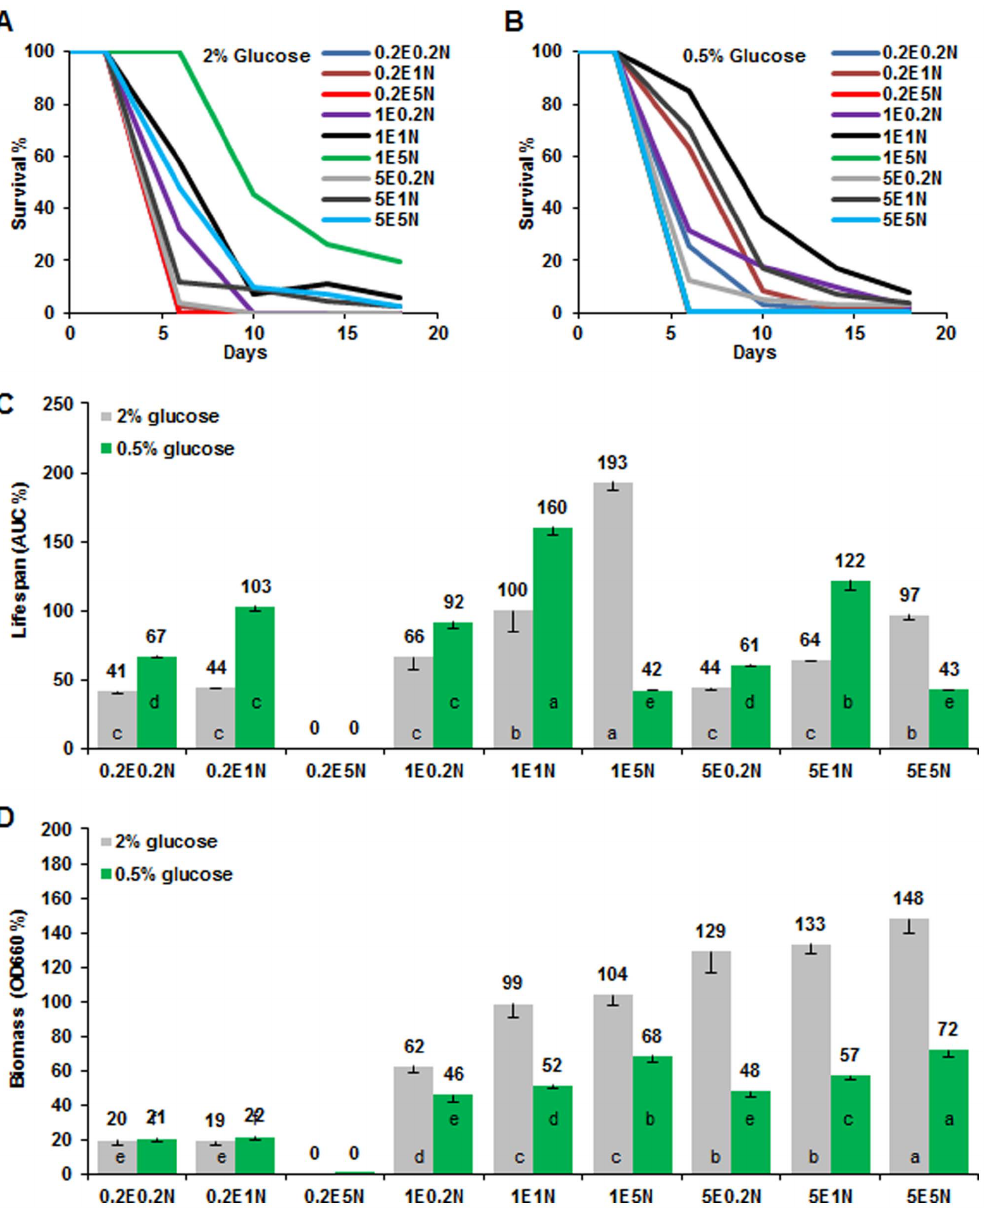
Figure 1. Ratio of essential and non-essential amino acids regulates lifespan and biomass changes. Survival curves of wild type yeast (BY4742) were cultured in SD media with different ratios of EAA (0.2 to 5 fold) and NEAA (0.2 to 5 fold) in normal (2% glucose, A ) and glucose restriction (0.5% glucose, B ) conditions. The normalized lifespan and biomass comparison were presented in C and D , respectively. All tests were based on SD media. 1E5N represents SD medium containing 1-fold EAA and 5-fold NEAA. The EAA and NEAA compositions and concentrations (1 fold) were listed in Table 1 . Area under the survival curve (AUC) represents the survival integral for lifespan comparison and AUC of the control (1E1N with 2% glucose) was defined as 100%. Biomass production was measured as the average values at OD660 of each medium from day 6 to day 10 and biomass of the standard SD medium (1E1N with 2% glucose) was defined as 100%. Lifespan and biomass: mean 6 s.e.m (n=4); compared using Duncan’s multiple range test at P , 0.01 and different lowercase letters in columns indicate significant